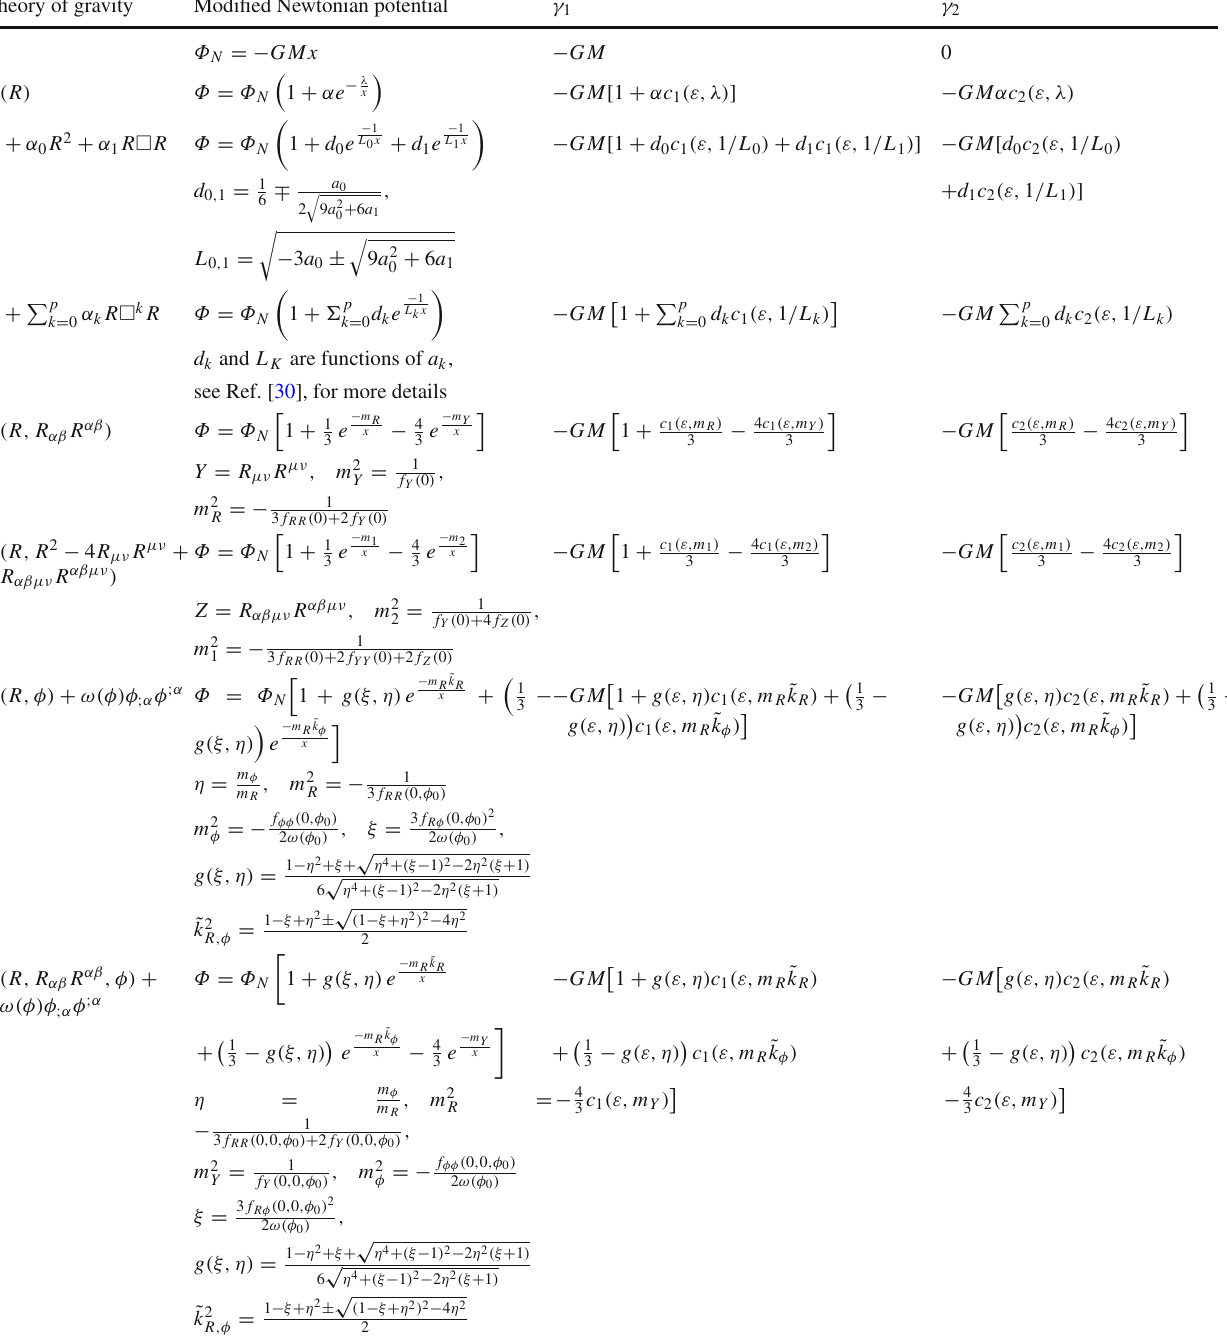
Table 1 Summary of different theories of gravity and related modified Newtonian potentials (see Table I in Ref. [30]), and the first two coefficients of the asymptotic expansion of the Φ potential, see Eq. (32). The first row refers to GR Theory of gravity Modified Newtonian potential γ 1 γ